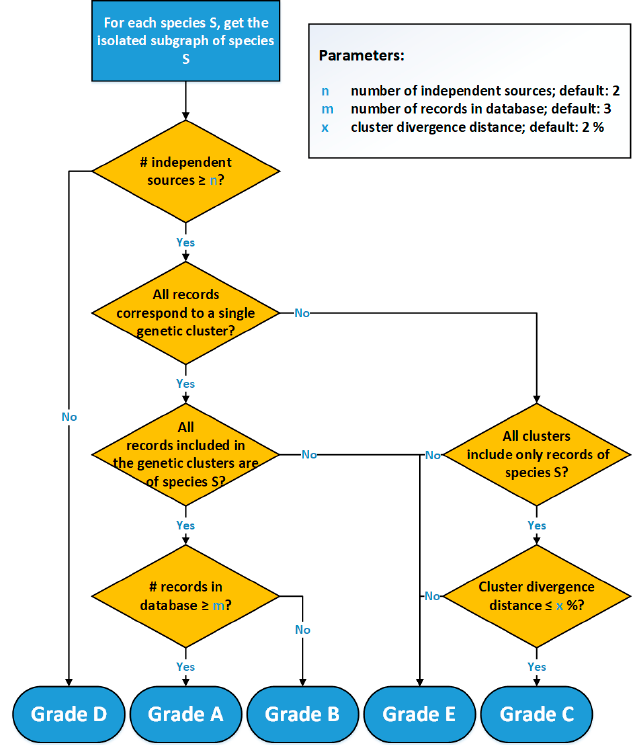
Figure 3. Flowchart of the 4SpecID implementation of the automated grading algorithm.